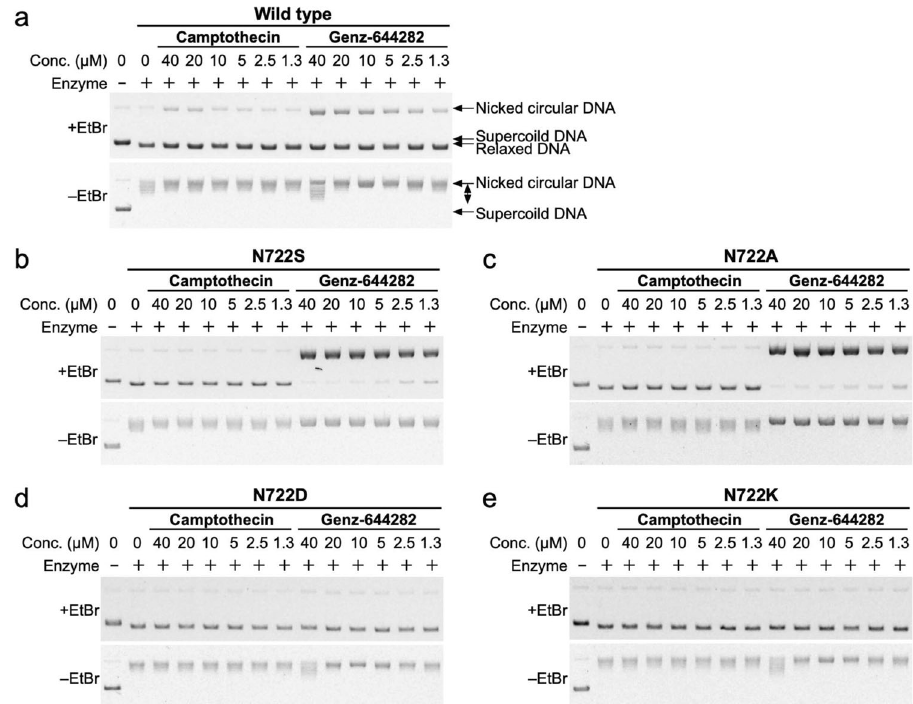
Fig. 8 Analysis of TOP1 inhibition by CPT and Genz in vitro. The DNA – TOP1 complex stabilised during the TOP1 reaction was detected as nicked DNA by agarose gel electrophoresis in the presence of 0.5 μ g/mL EtBr. Relaxation of supercoiled DNA by TOP1 was detected by agarose gel electrophoresis in the absence of EtBr. a The wild-type TOP1 was treated with CPT and Genz, and nicked DNA was detected by agarose gel electrophoresis in the presence of EtBr. ( b – e ) TOP1 N722S ( b ), N722A ( c ), N722D ( d ), and N722D proteins ( e ) were treated with CPT and Genz, and nicked DNA was detected by agarose gel electrophoresis in the presence of